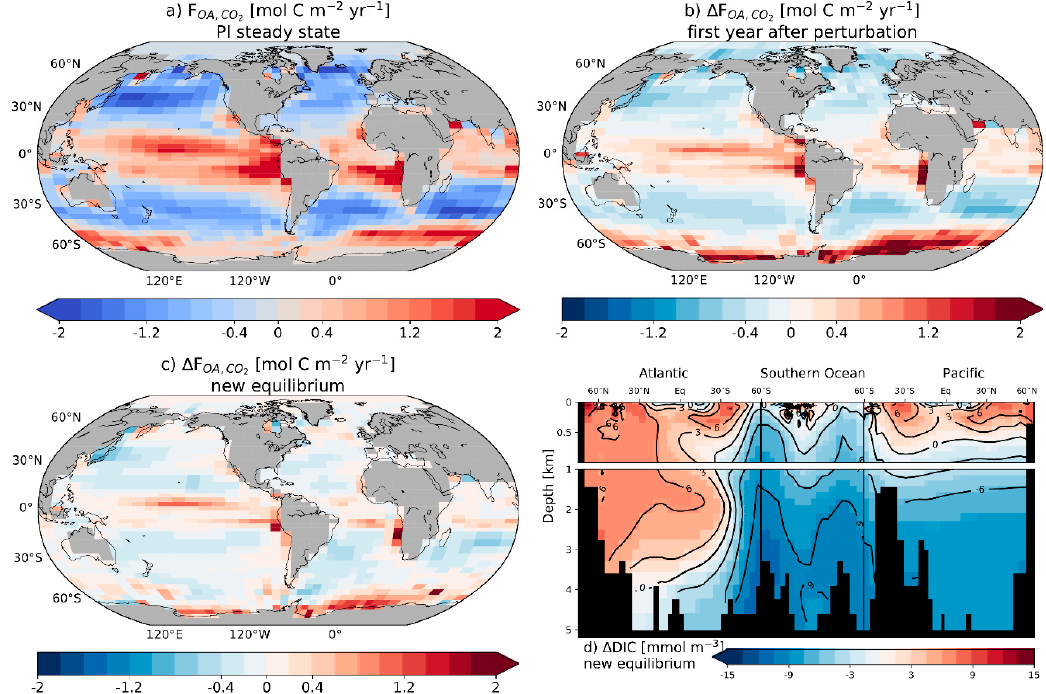
Figure 9. Maps and section of variables of interest as simulated by the Bern3D ocean model. ( a ) Ocean-atmosphere flux of CO 2 for preindustrial steady state conditions. ( b ) Changes in the ocean-atmosphere flux of CO 2 in the first year after introducing a nonzero intercept for the gas transfervelocityofCO 2 . ( c )Changesintheocean-atmospherefluxofCO 2 fornewsteadystateconditions (year 5000). ( d ) Changes in dissolved inorganic carbon concentrations in a section through the Atlantic (25 ◦ W), across the Southern Ocean (58 ◦ S), and into the Pacific (175 ◦ W) for new steady state conditions. Changes are expressed relative to a control run that used a zero intercept parameterization